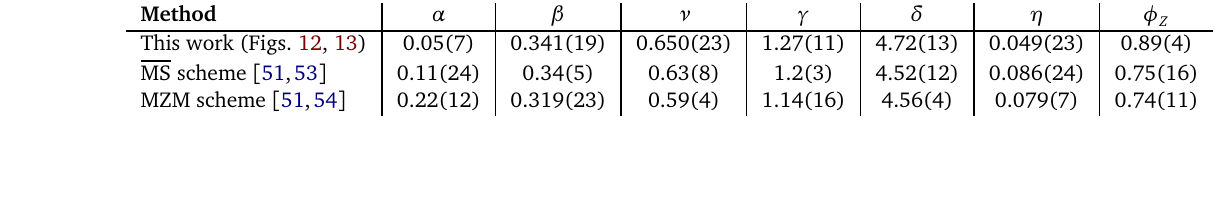
Table 5: O ( 2 ) × O ( 2 ) critical